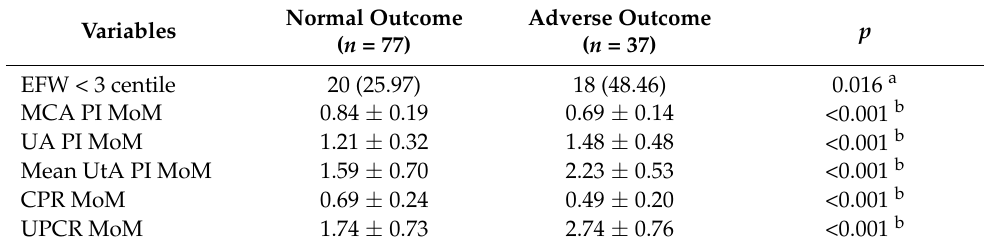
Table 2. Ultrasound Doppler indices of the pregnant women enrolled.